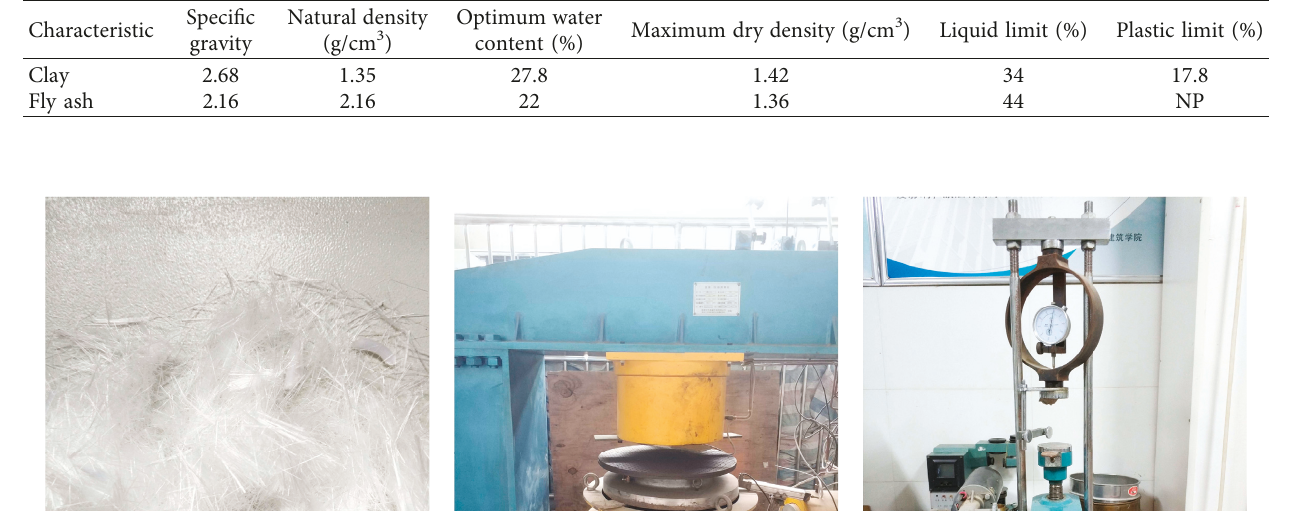
Table 1: Physical parameters of clay and fly